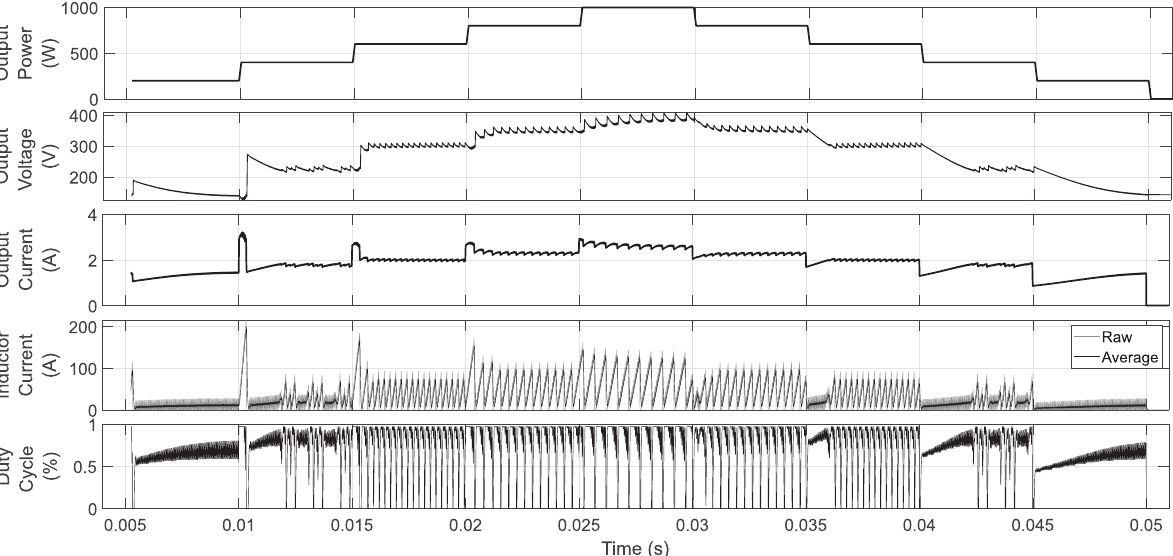
Figure 12. CPL sweep in closed-loop operation. The duty cycle never reaches the upper limit (set to 0.95), and a DCM operation is achieved at almost all times.